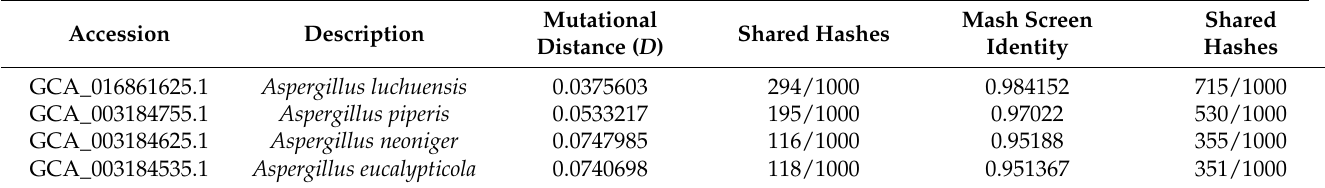
Table 3. Genomic coherence for a set of long-reads of strain C7 against representative closest fungal genomes.